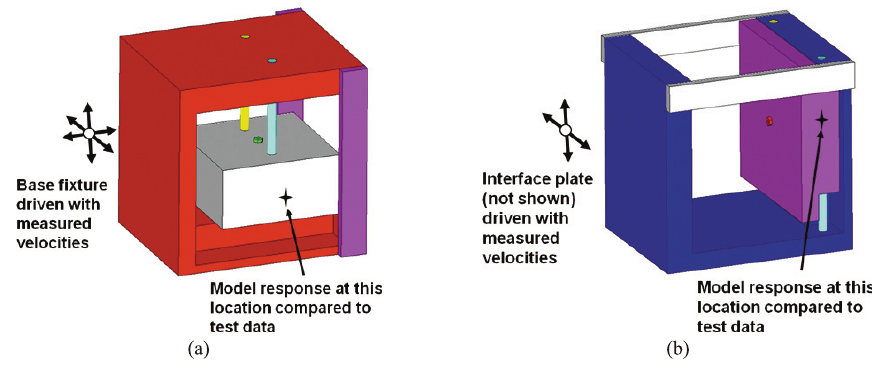
Fig. 6. Schematic of the model for (a) dynamic tension; and (b) dynamic